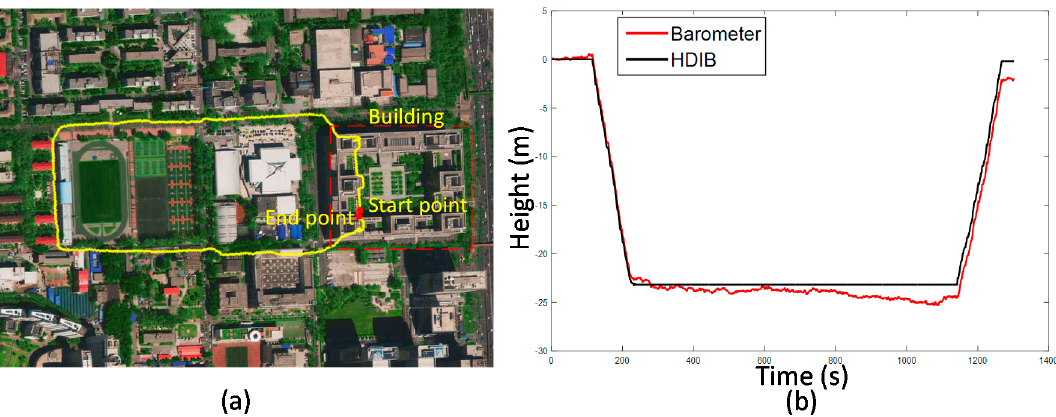
Figure 32. Positioning result of Traj_5 overlaid on a satellite campus picture; ( a ) is the top view; ( b ) is height estimation result. TTDE of this test is 0.63% and the height error is 0.20 m.